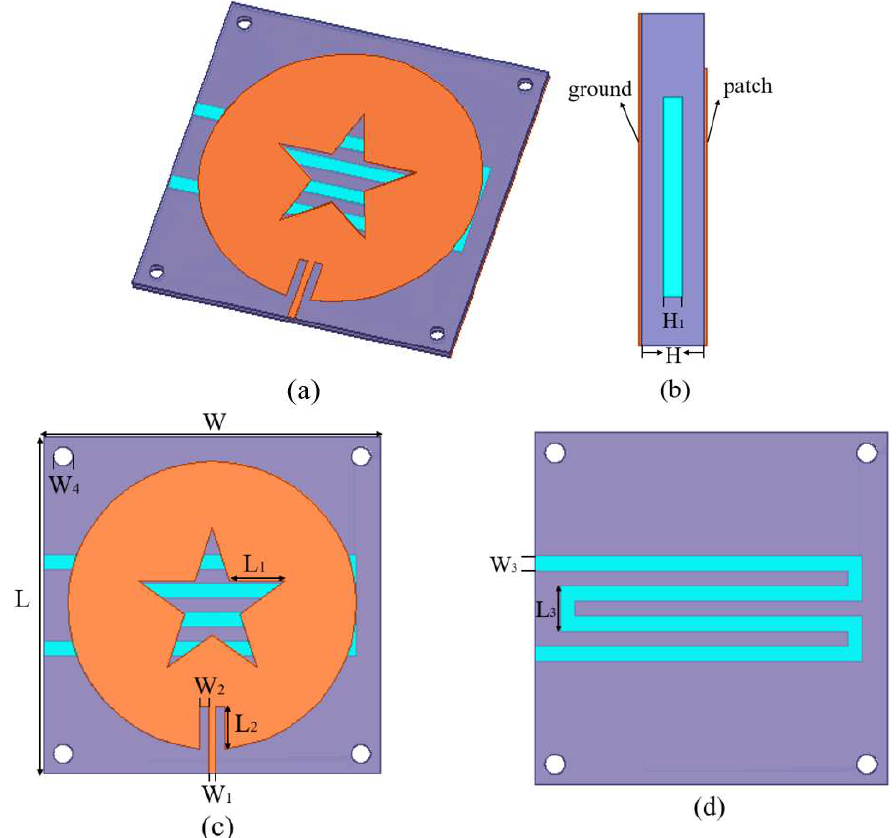
Figure 1. The structure of the microwave sensor: ( a ) 3D view; ( b ) side view; ( c ) the radiation patch; ( d ) the microfluidic channels.